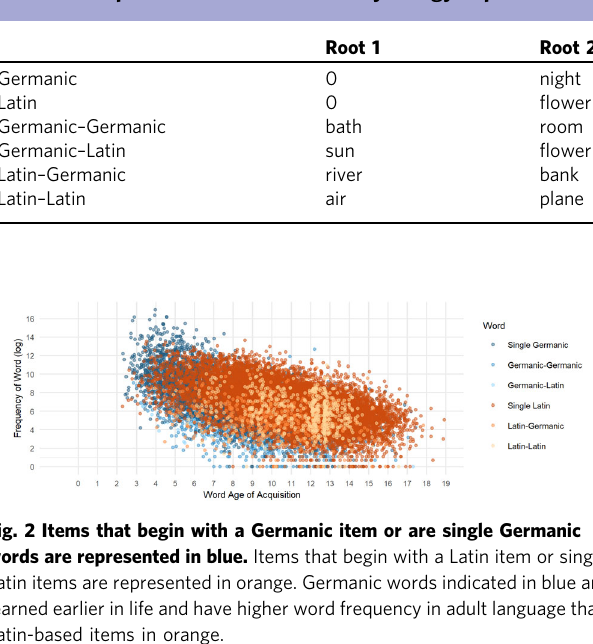
Table 1 Sample stimuli for the word etymology experiment.